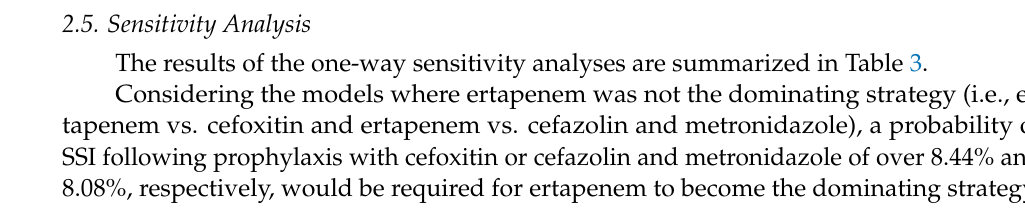
Figure 3. Cost-effectiveness analysis of ertapenem compared to standard prophylactic regimens in elective colorectal surgery. ( a ) Ertapenem vs. amoxicillin-clavulanate; ( b ) Ertapenem vs. cefoxitin; ( c ) Ertapenem vs. cefazolin plus metronidazole.